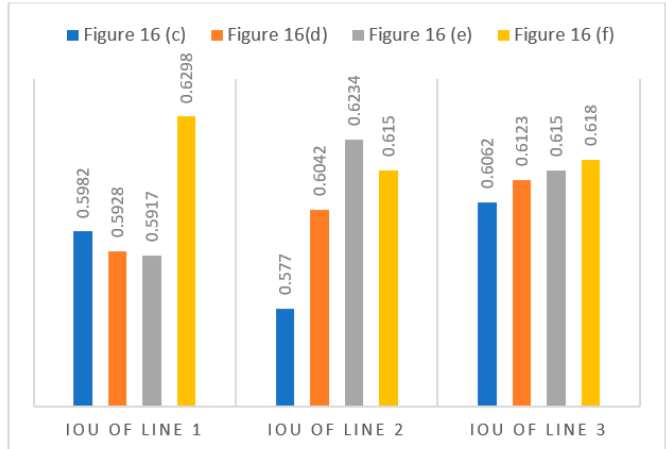
Figure 17. IoU scores of the methods in Figure 16.